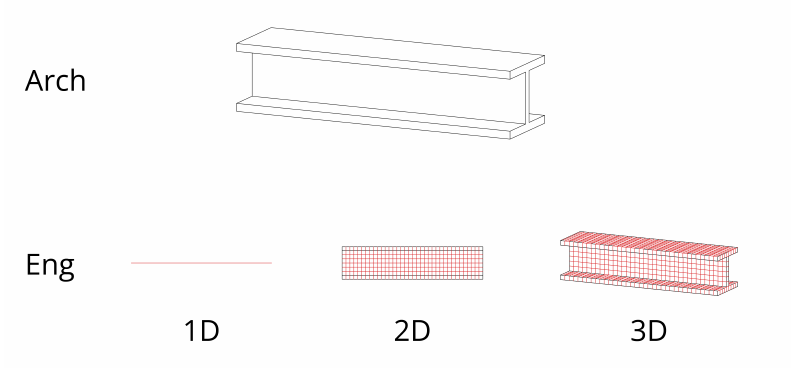
Figure 3. The architectural model of a beam represented as 1D, 2D, and 3D analytical